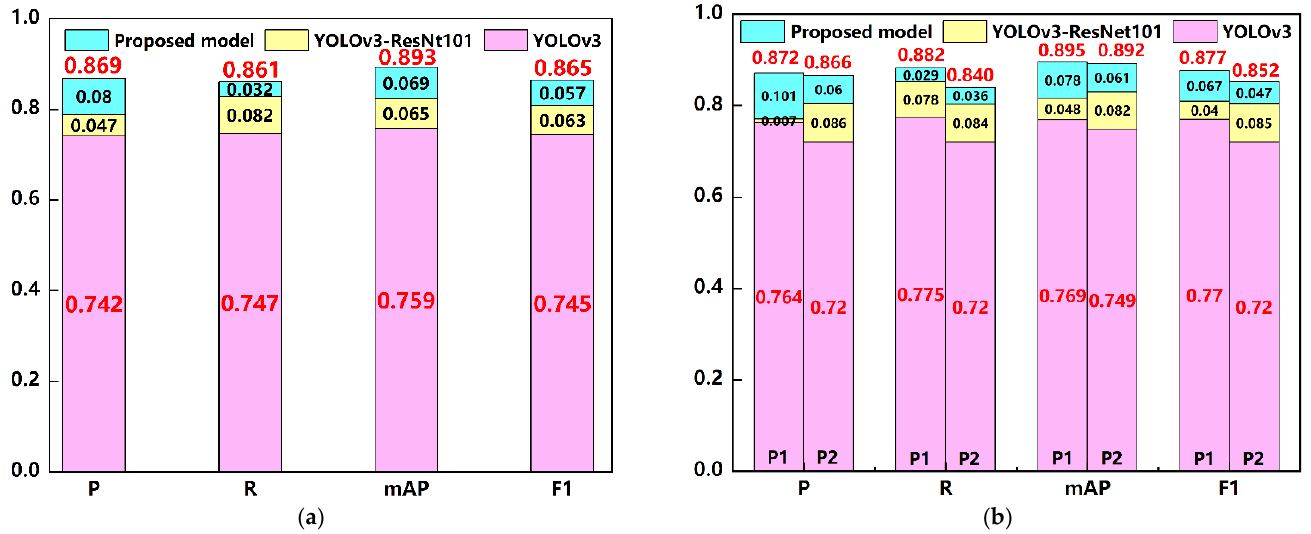
Figure 10. Evaluation indices of YOLOv3 model and other improved models. ( a ) overall evaluation indices; ( b ) evaluation indices of P1 and P2 labels.